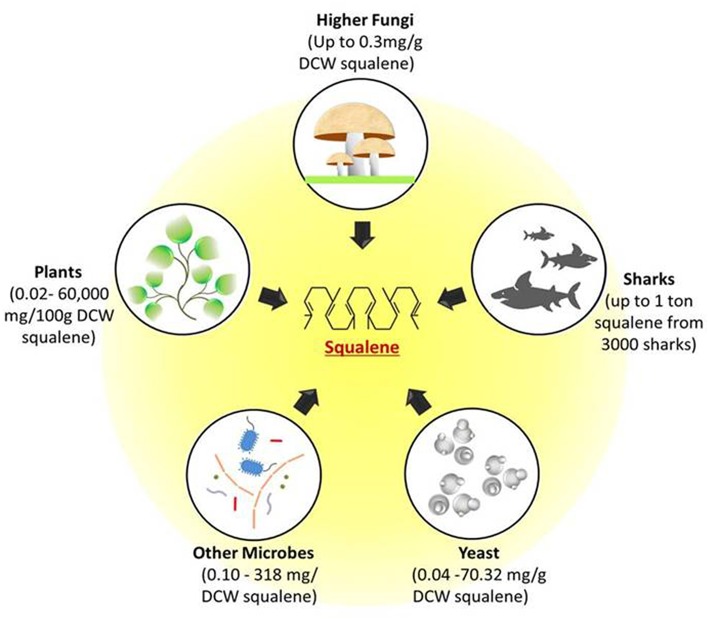
Potential natural sources of squalene. Figure depicts the possible squalene sources ranging from unicellular microbes such as yeast and other bacterial cells to multicellular fungi, plants, and deep sea sharks. All these sources can produce squalene through mevalonate pathway. DCW, Dry cell weight.